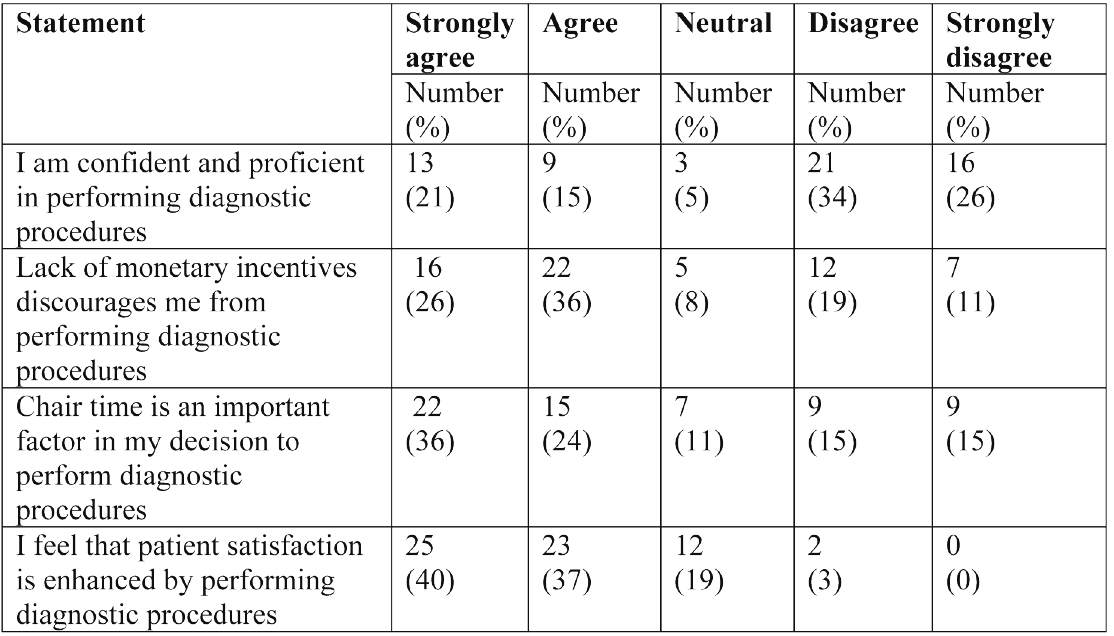
Table 2: The percentage responses of optometrists who were certified in diagnostic procedures to various statements on the proce - dures are shown.